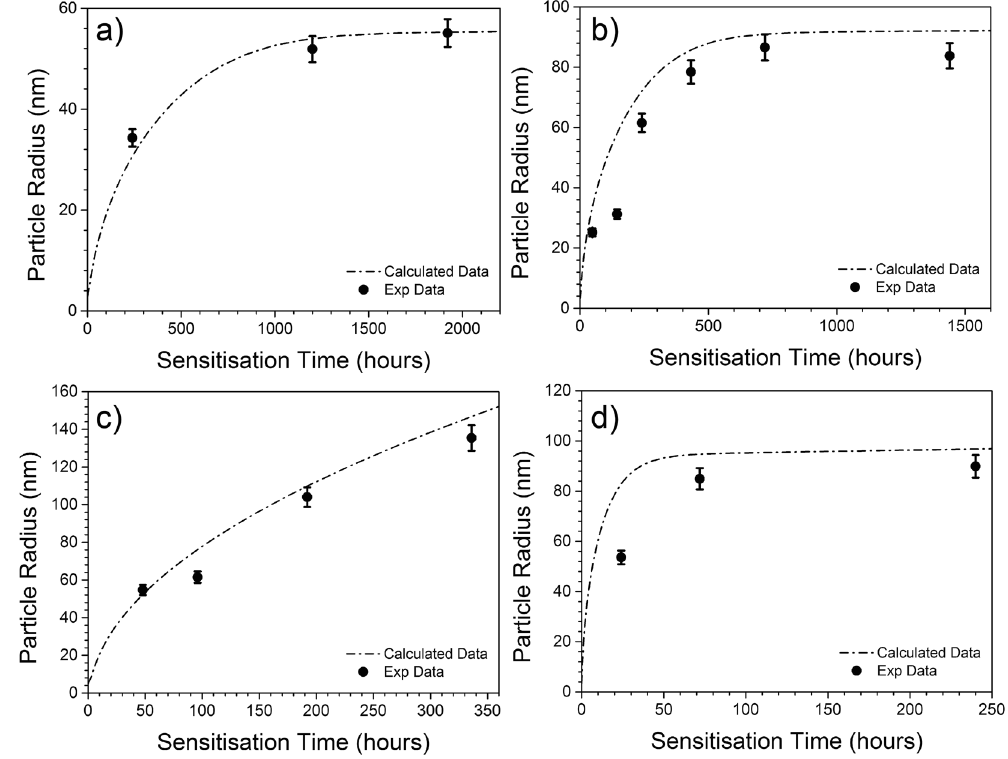
Figure 6. Average radius of grain boundary β -phase (Mg 2 Al 3 ) from HR-SEM images and simulation of particle radius from a modified CALPHAD based model for AA5083 sensitised at ( a ) 80 °C ( b ) 100 °C ( c ) 150 °C and ( d ) 200 °C for various times. The standard deviation of the mean particle radius is between 20% and